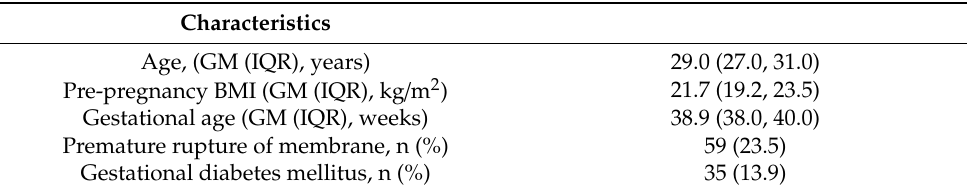
Table 1. Characteristics of the mothers ( n = 251).